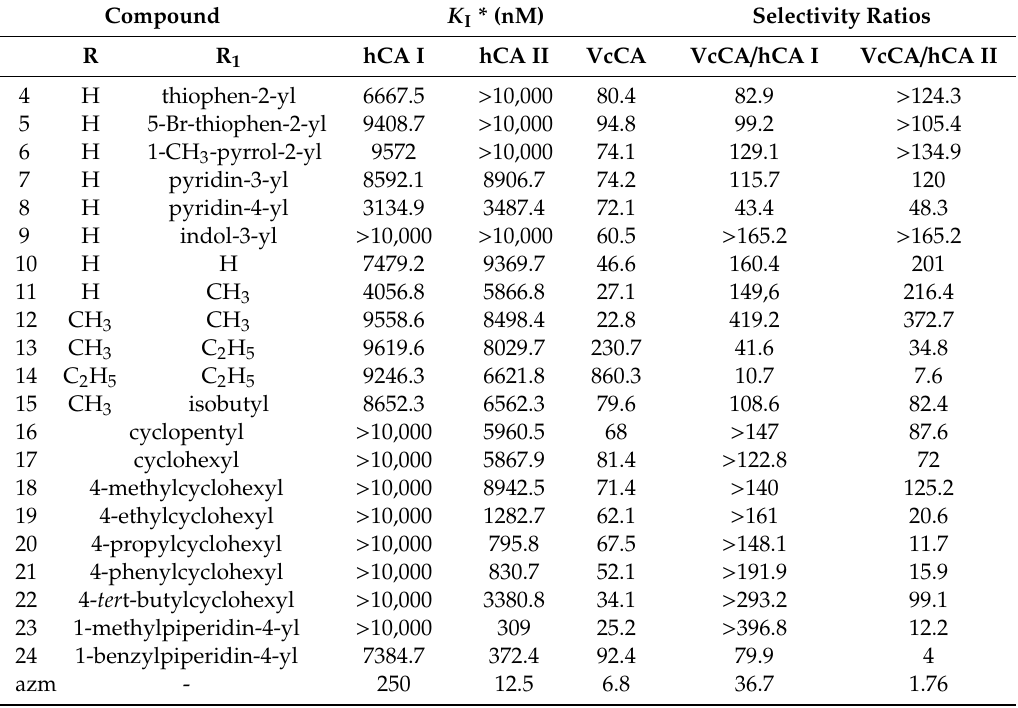
Table 1. Inhibition data against human (h) isoforms hCA I, II (cytosolic), and bacterial enzyme VcCA of derivatives 4–24 and azm by a stopped-flow CO 2 hydrase